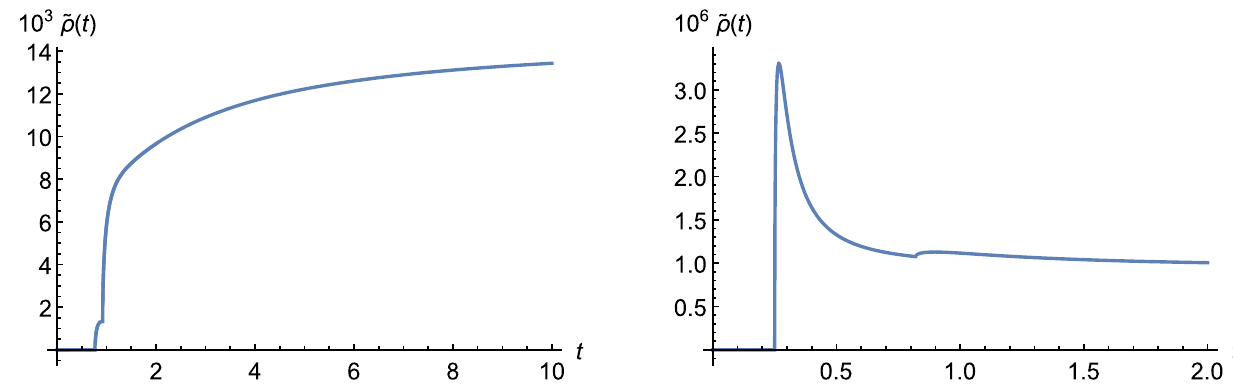
Fig. 12 Spectral function for the propagator (cid:2) h ( p ) h ( − p ) (cid:3) in the unitary gauge, with t given in unity of μ 2 , for the Region I (left) and Region II (right), with parameter values given in Table